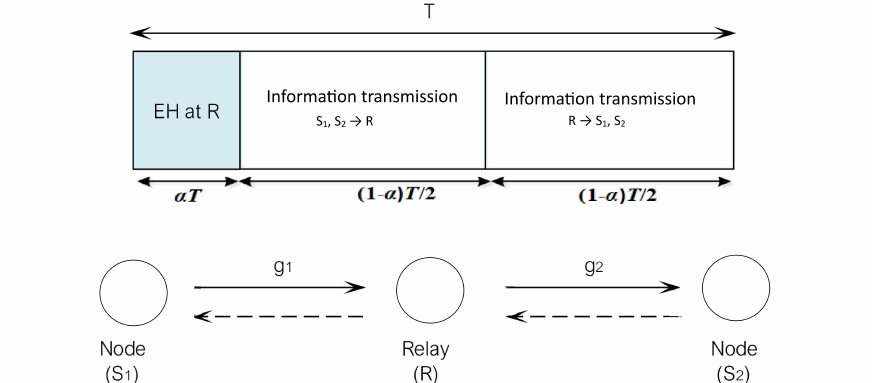
Figure 1. The proposed wireless sensor network (WSN) model with bidirectional relaying, 2019 IEEE